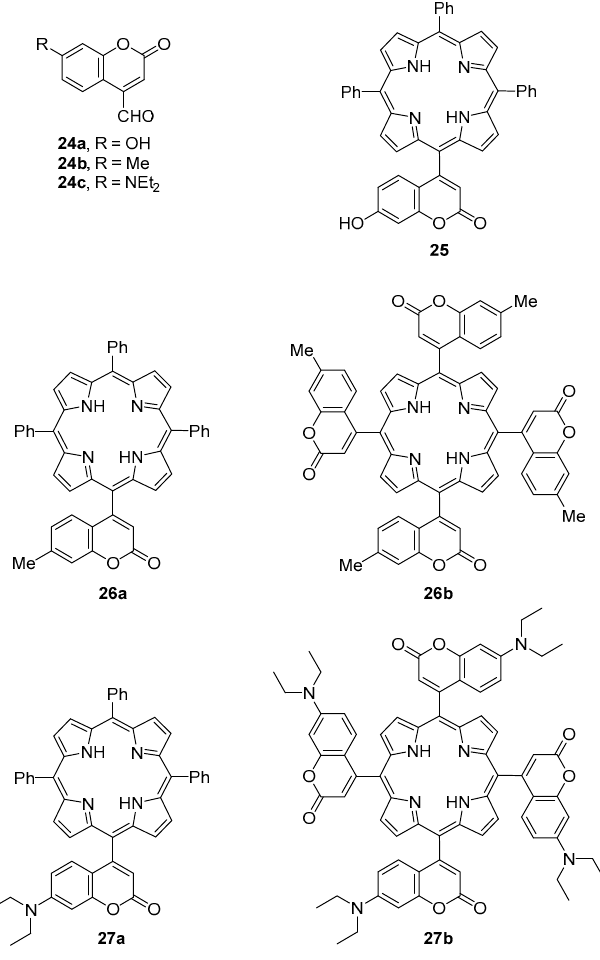
Figure 2. meso -(Coumarin-4-yl)porphyrins reported by Lin et al. [49].